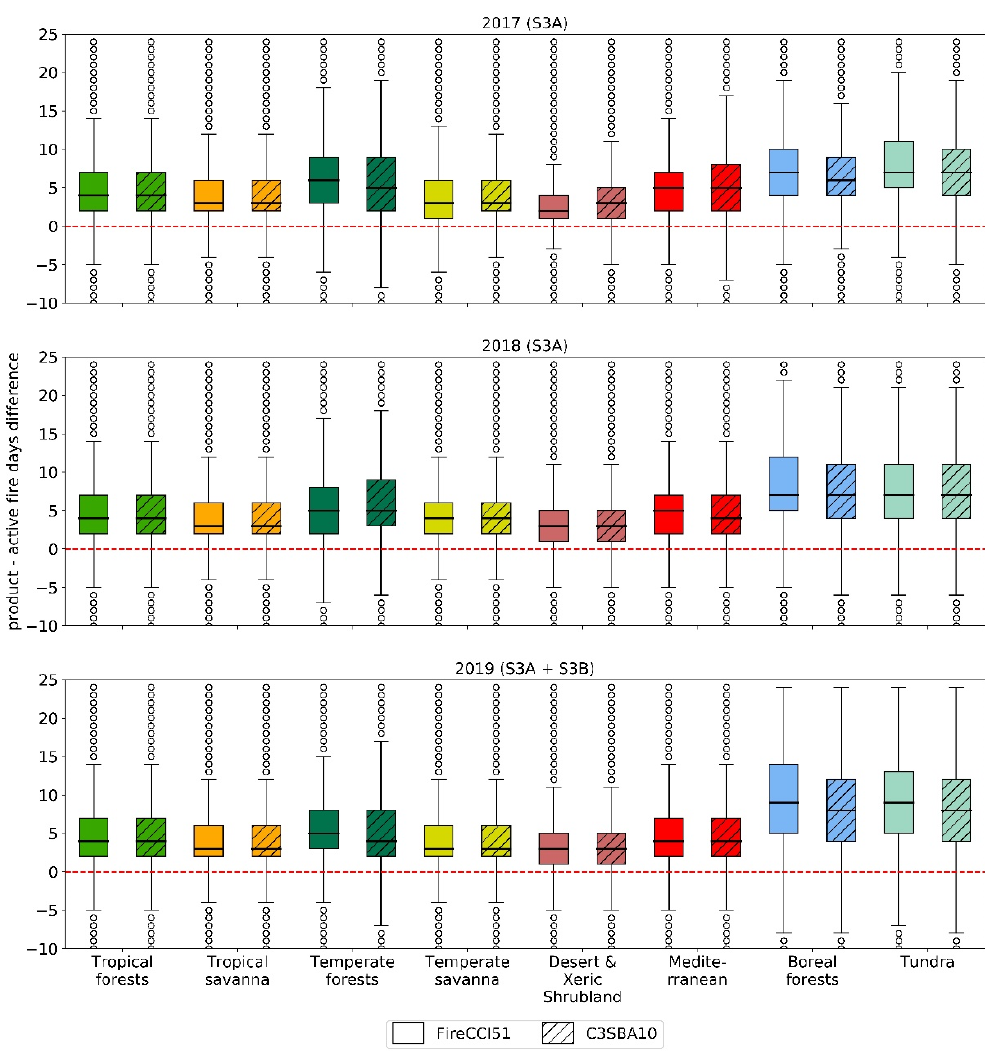
Figure 8. Temporal reporting accuracy assessment of both FireCCI51 and C3SBA10 products. The box represents the interquartile range (IQR), the lower and upper bounds being the 25th and 75th percentiles, respectively. The black line within the box corresponds to the median value. The whiskers represent an additional area of 1.5 ×